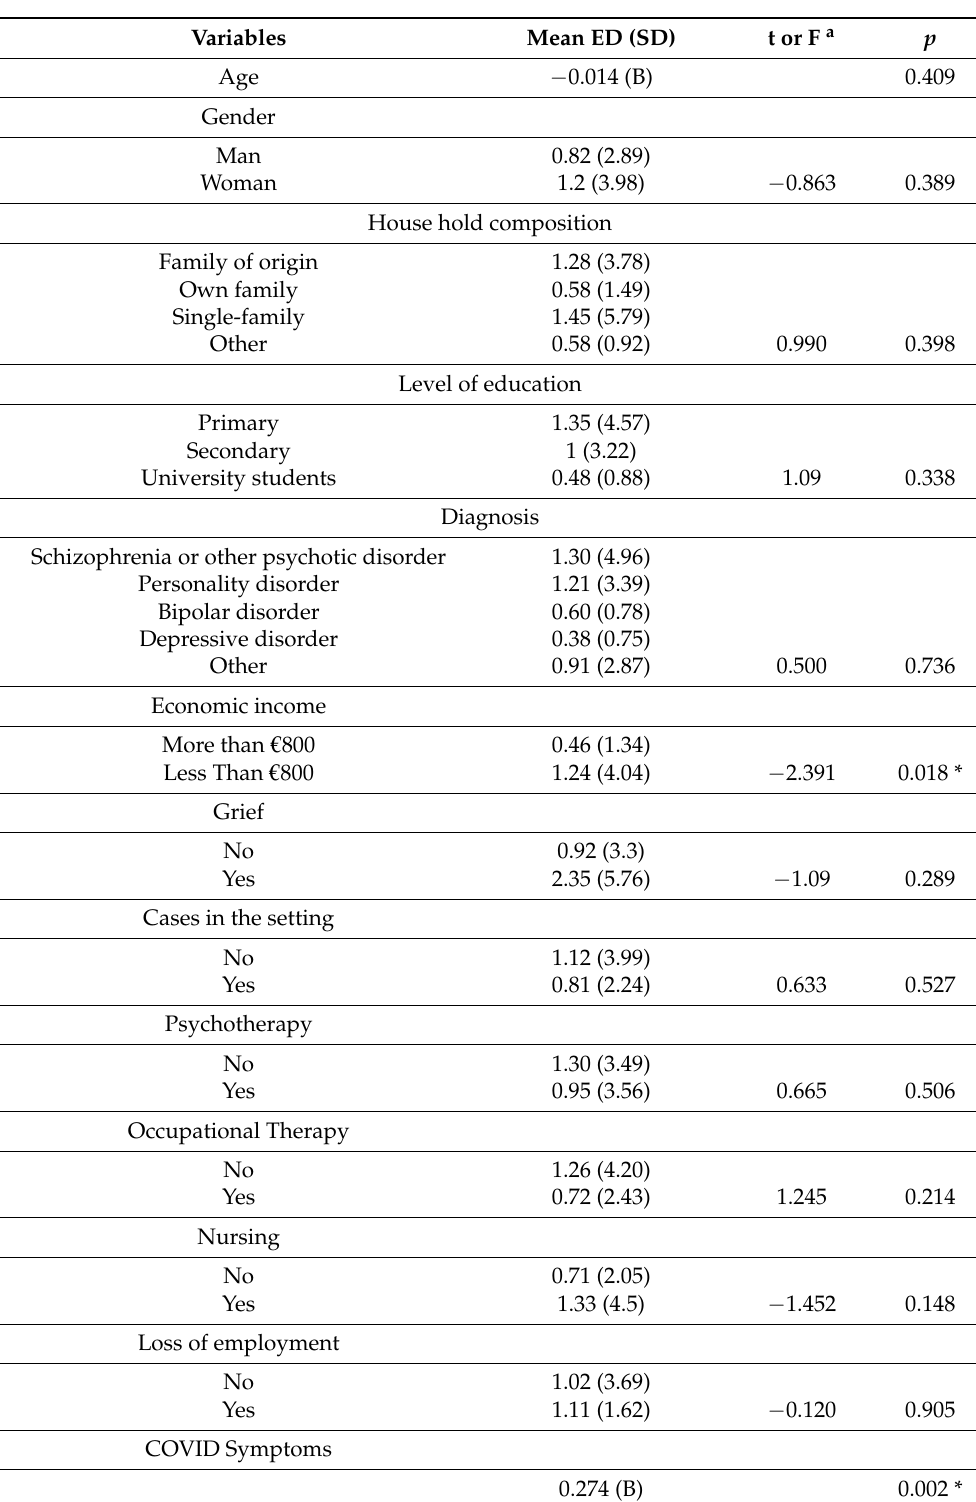
Table 2. Bivariate analysis of the number of urgent mental health consultations as a function of different